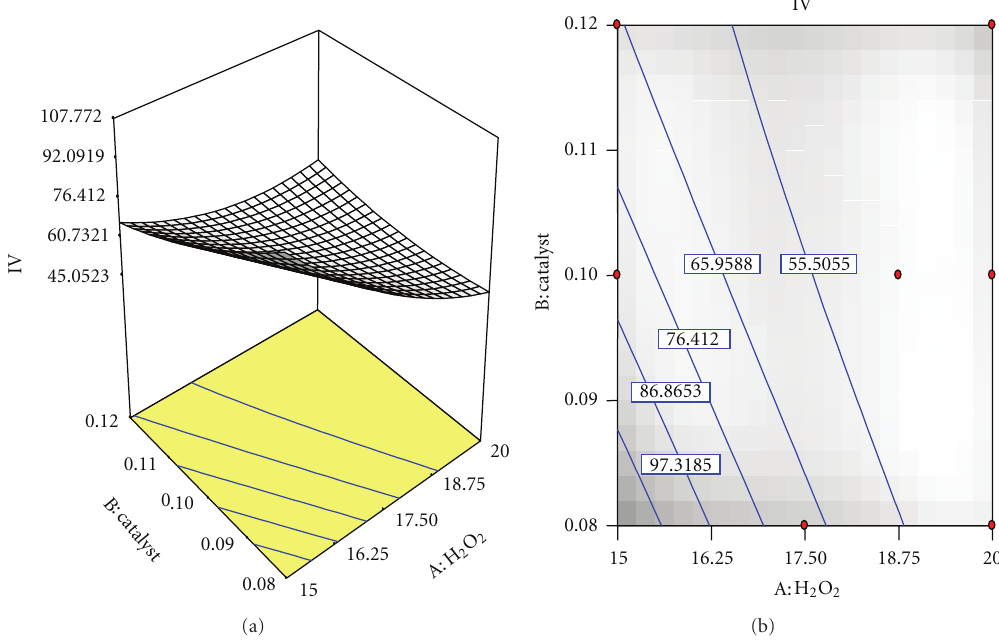
Figure 5: Response surface (a) and contour plots (b) for the e ff ect of the H 2 O 2 ( X 1 , μ L) and catalysts Novozym 435 ( X 2 , mg) on the IVmg/g of MEOA.